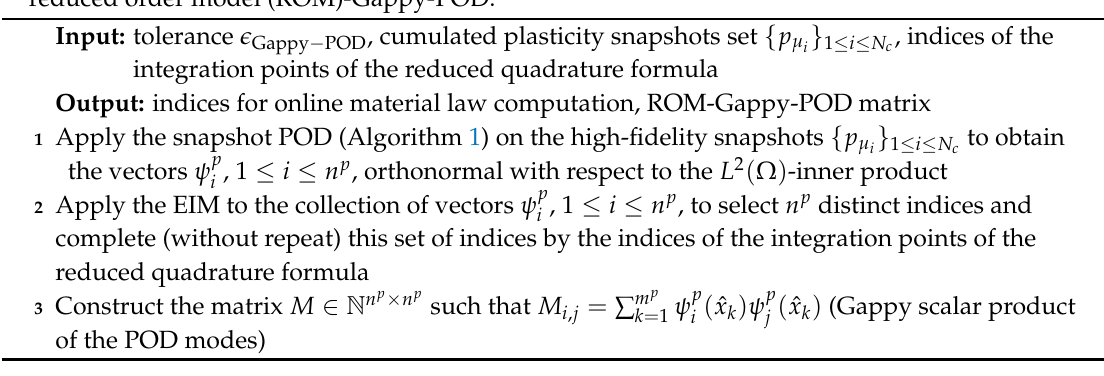
Algorithm 3: Dual quantity reconstruction of the cumulated plasticity p : offline stage of the reduced order model (ROM)-Gappy-POD.